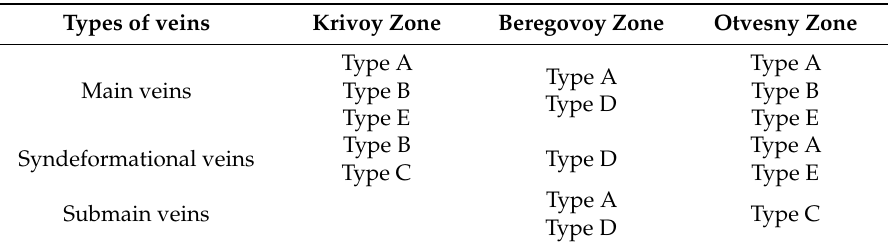
Table 1. Types of the microstructures of quartz veins of various structural positions